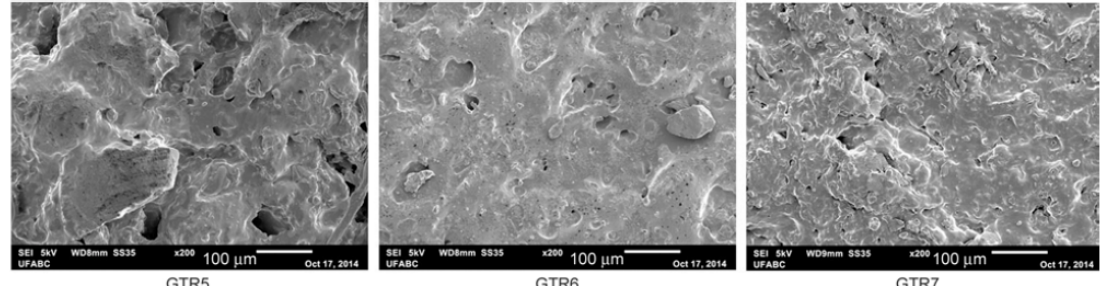
Figure 13. Typical SEM images of the surface sheets of different GTR microwave treated for 5 (GTR5), 6 (GTR6) and 7 (GTR7) minutes (reproduced with permission from [21]). Zanchet et al. [104] regenerated SBR via microwave exposure for 1, 2 and 3 min and blended the regenerated SBR (rSBR) with virgin SBR (20 phr) for subsequent revulcanization. As presented in